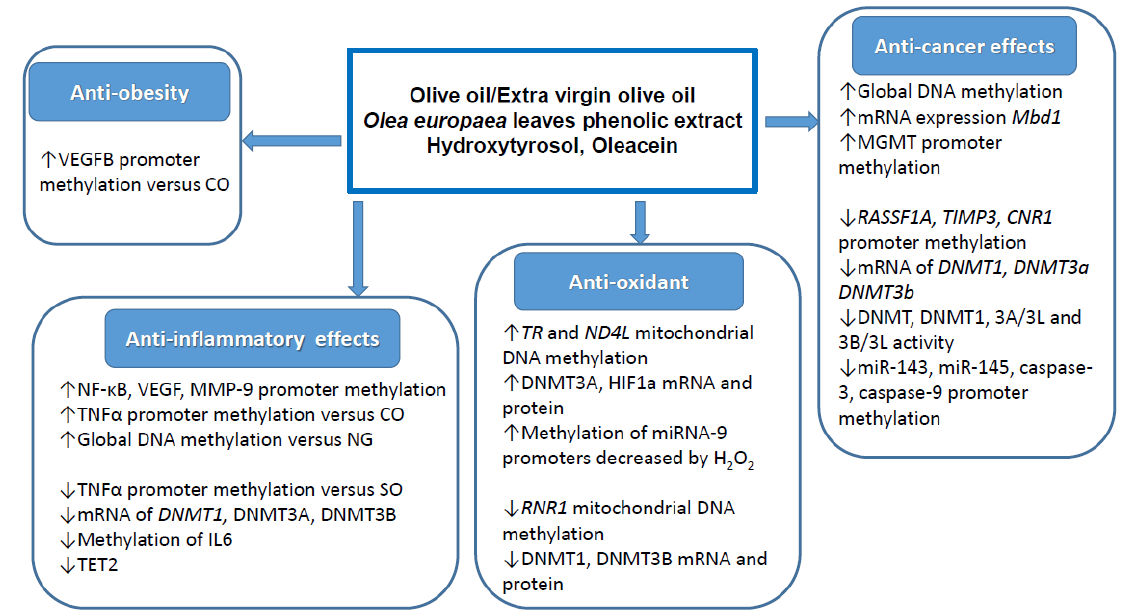
Figure 3. Main effects of olive oil and/or its phenolic compounds on DNA methylation in relation to different biological and healthy properties. “ ↑ ” and “ ↓ ” indicate increment and decrement of DNA methylation, respectively.